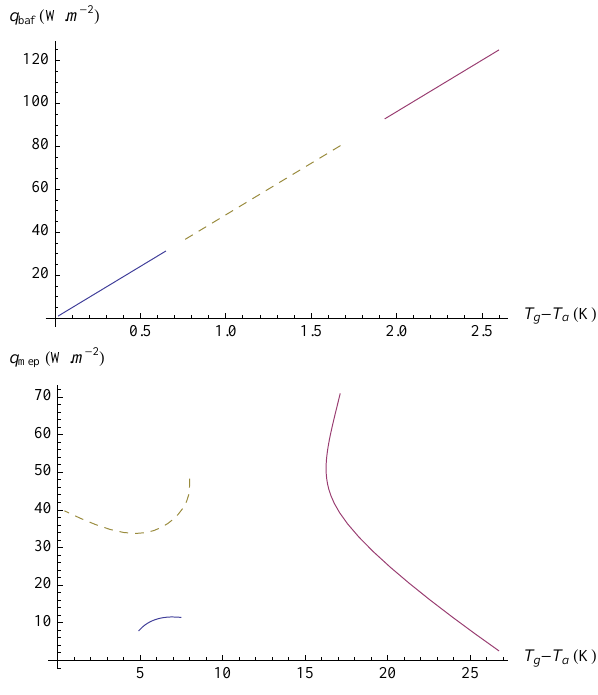
Fig. 12. Comparison between the bulk aerodynamic formula sur- face heat flux (top) and the MEP predicted surface heat flux (bot- tom) as a function of the temperature gradient T g − T a . The red solid line corresponds to the warm branch of the bifurcation diagram, the blue solid line to the snowball state and the dotted yellow line is the unstable branch. Note the very different scales for T g − T a